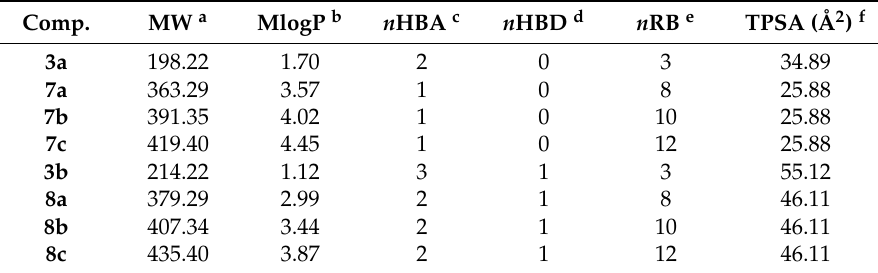
Table 3. Physicochemical descriptor calculated by the SwissADME simulation.